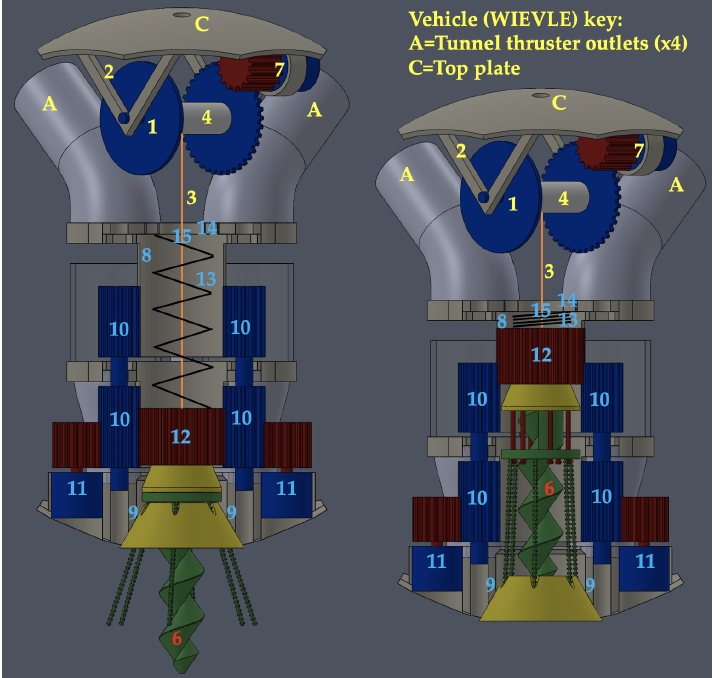
Figure 4. RAATM anchor sleeve assembly components in the rooted ( left ) and the stowed ( right ) positions. The anchor sleeve (8) is a cylindrical tube positioned below the tether spool (1) that contains the deployable anchor assembly. It consists of a fixed cylindrical tube joined to a beveled, notched anchor port (9) at the base of the hull. The anchor port retains the anchor plug by permanent magnetic inserts in the base of the anchor plug and the anchor port walls. The cylinder extends upward, terminating just below the tether spool (1), and it contains vertical slots that enable the interfacing of corresponding vertical spur gears (10), driven by electric actuators (11) adjacent to the anchor plug, extending upward and engaging with the corresponding outer splines of the anchor cap coupler (12)—a vertically-splined, externally cylindrical and internally conical (concave) spur gear. The anchor cap coupler is compressed by the anchor spring (13) onto a corresponding (convex) conical spur gear that serves as the anchor cap. The anchor cap coupler has a small, beveled, central guide hole allowing the swivel eyelet (5) to insert and the tether (3) to pass through. The anchor spring (13) glides smoothly within a groove at the top of the anchor cap coupler (12) to allow the anchor cap coupler to rotate freely inside the anchor sleeve (8). The anchor sleeve cap (14) is fixed at the top of the anchor sleeve (8) and retains the anchor spring (13) to enable compression. The anchor sleeve cap (14) contains a central guide hole (15), reinforced with a Teflon insert, to resist abrasion from the tether and damage to the tether, reduce friction, and center the tether onto the tether spool (1). The tether spool